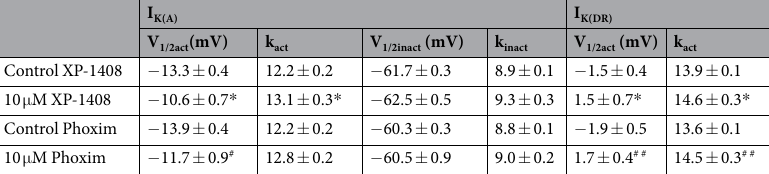
Table 3. Changes in kinetics of I K(A) and I K(DR) activation/inactivation properties in response to XP-1408 and phoxim applications. Values are the mean ± SEM, * P < 0.05 vs. control XP-1408 , # P < 0.05 vs. control Phoxim , # # P < 0.01 vs. control Phoxim